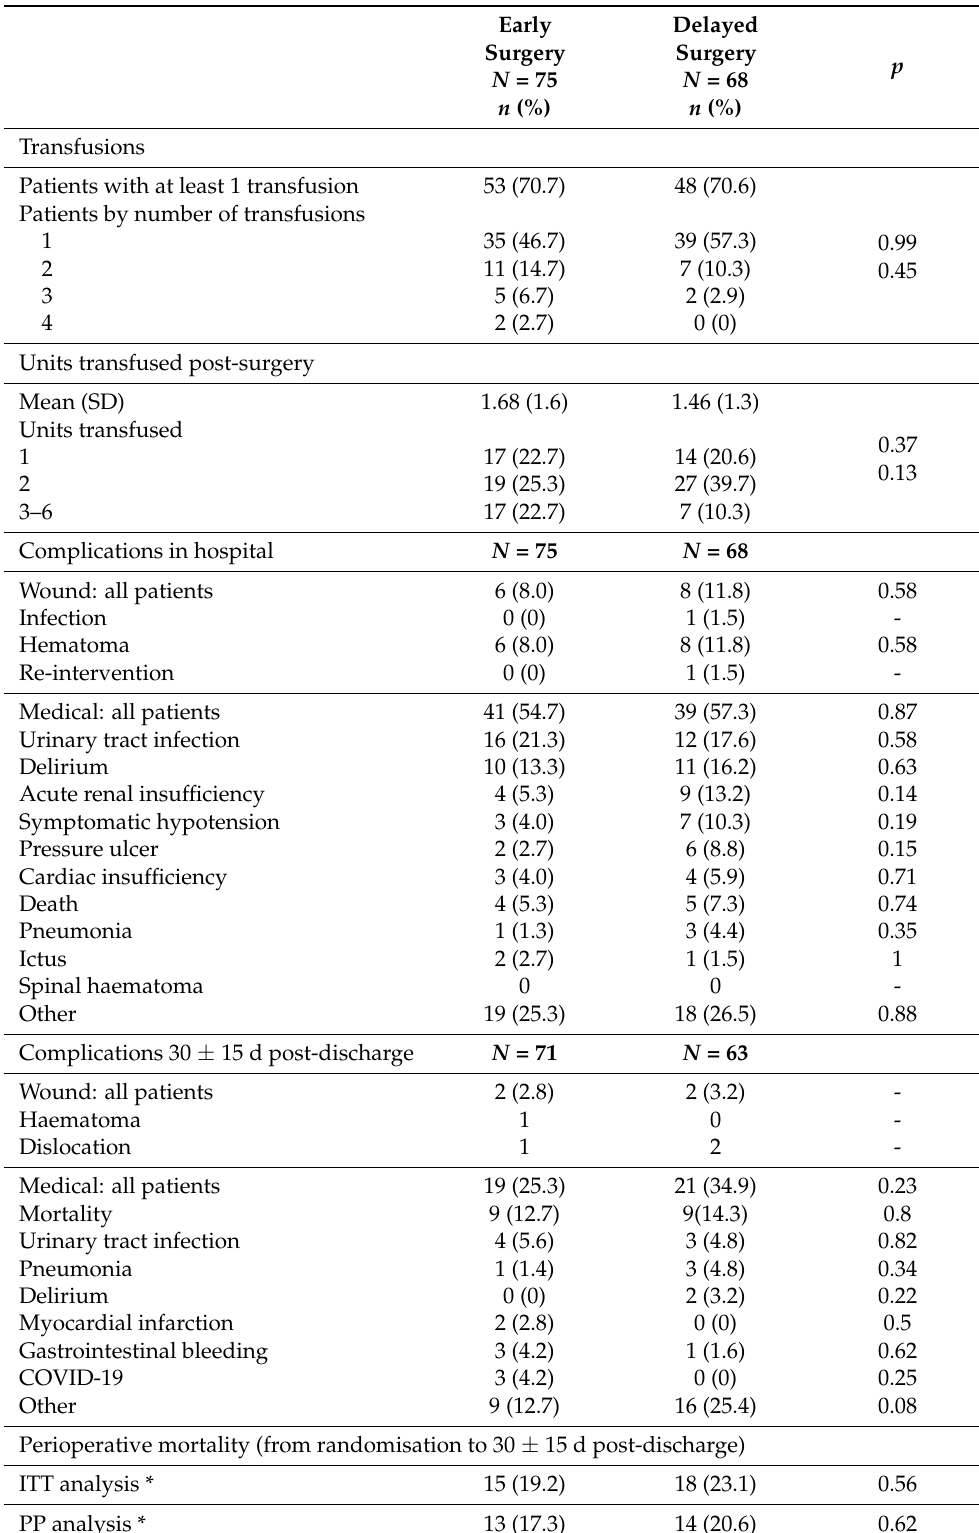
Table 4. Perioperative complications and